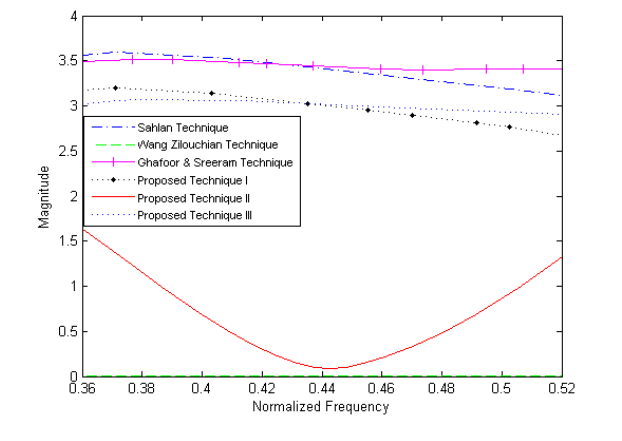
Fig. 1. Error comparison - zoom-in view